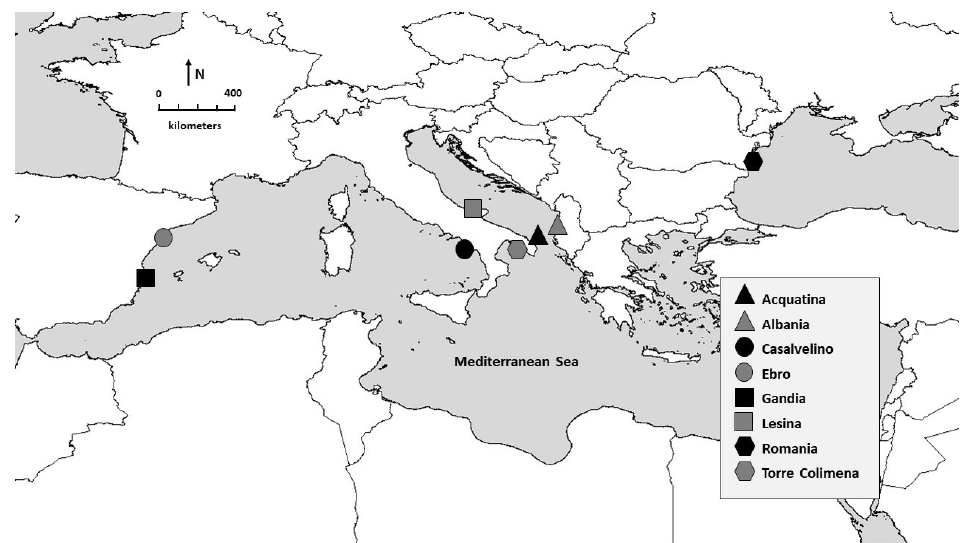
Figure 1. Geographical representation of sampling locations of Callinectes sapidus specimens used in the current study.